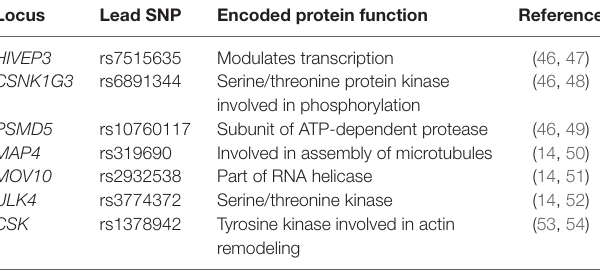
Table 2 | Novel SNPs linked to elevated BPs identified through GWAS.